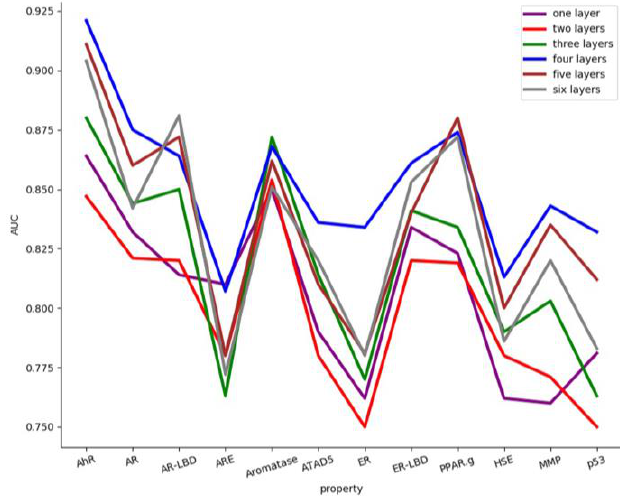
Figure 6. The area under the curve (AUC) of 12 properties with different hidden layers. The different colors represent 12 AUC values with different hidden layers.